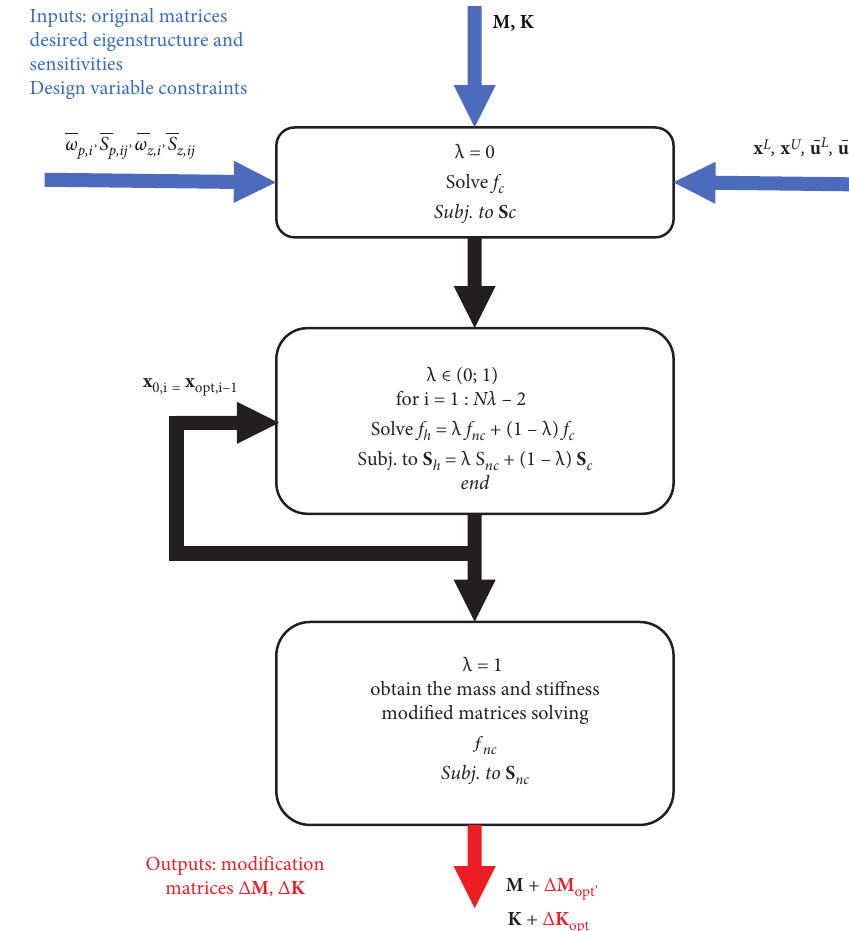
Figure 1: Flowchart of the solution